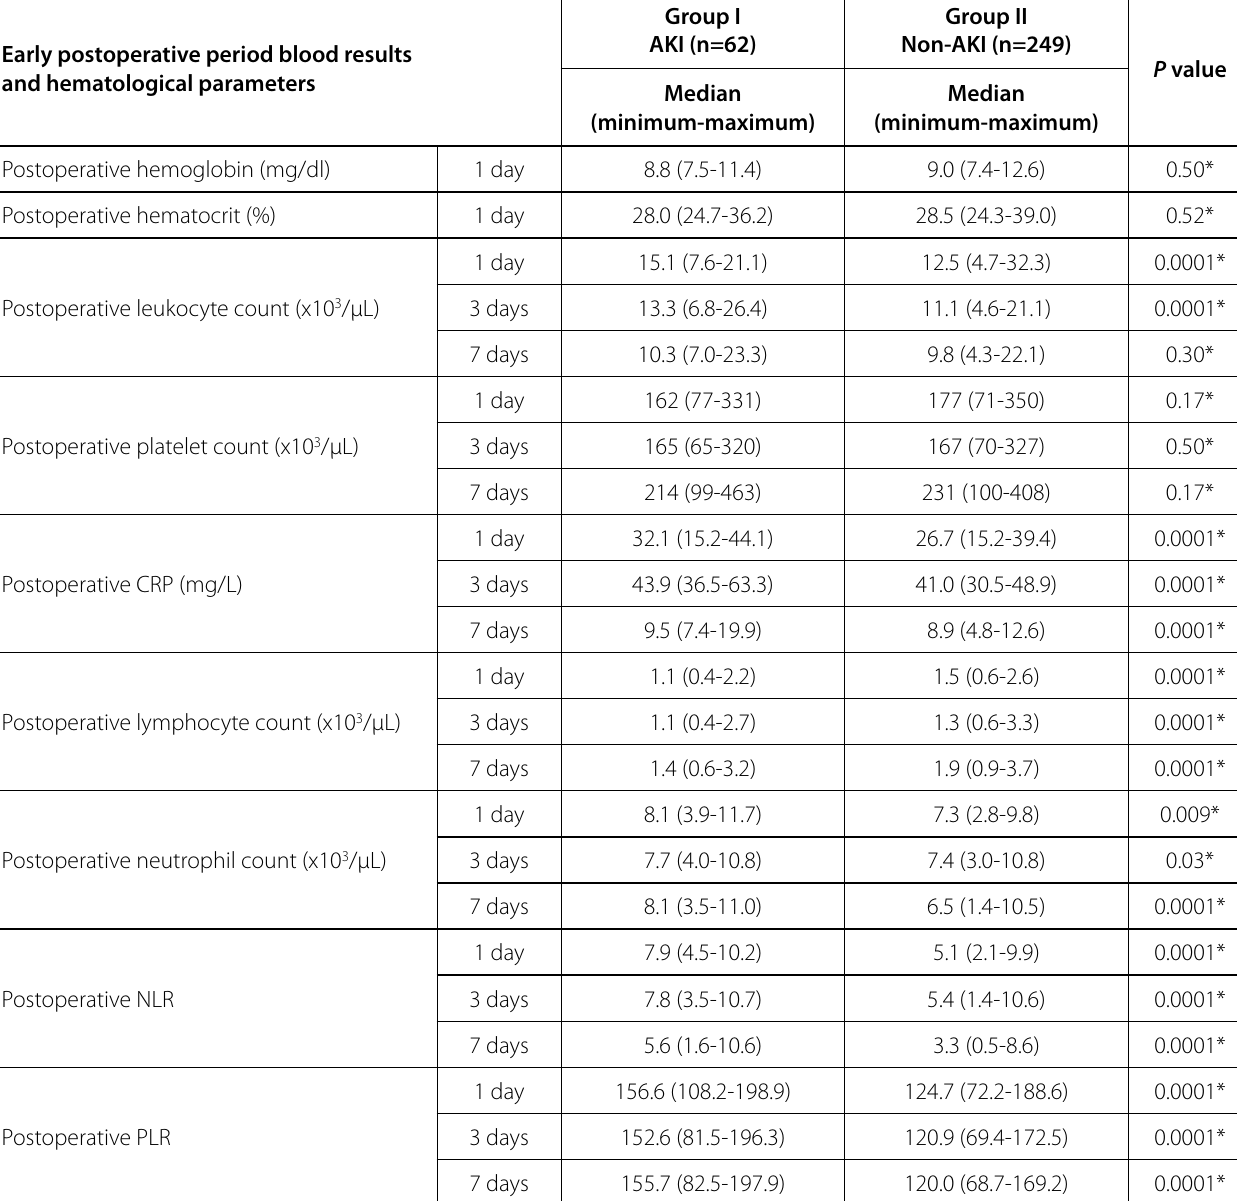
Table 3 . Early postoperative blood results and hematological parameters of patients.